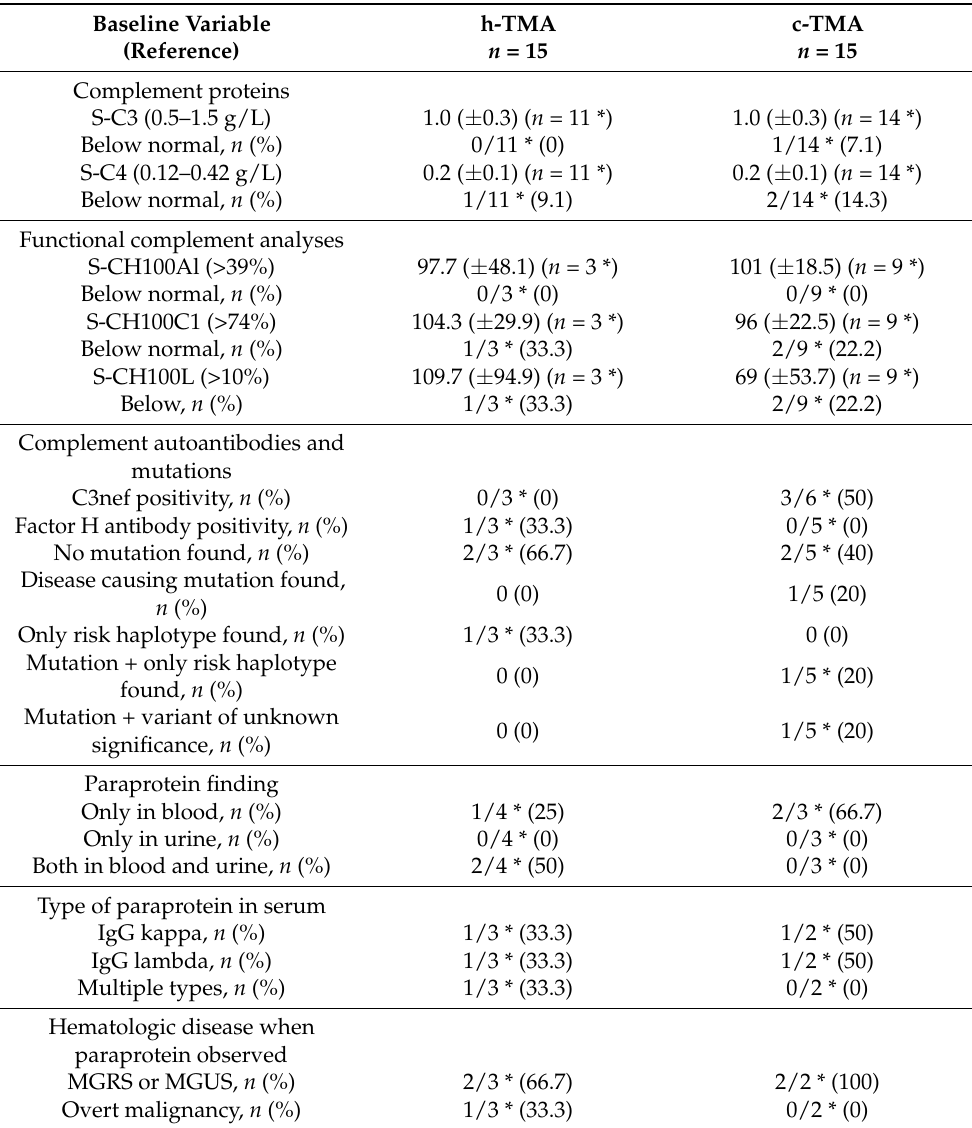
Table 4. Complement and paraprotein evaluation at the time of diagnosis. Reference values and units are shown in parenthesis. Values are expressed as means ( ± SD), or number of patients (percentages). p -values were not